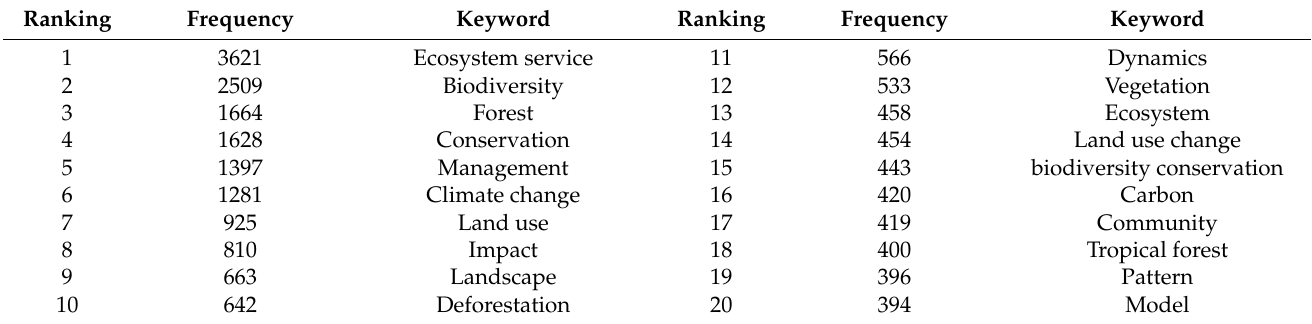
Table 5. Top 20 keywords used in published articles on FES-related topics from 1997 to